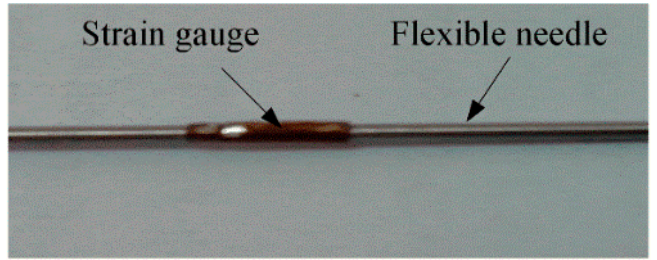
Figure 4. Needle with a strain gauge.